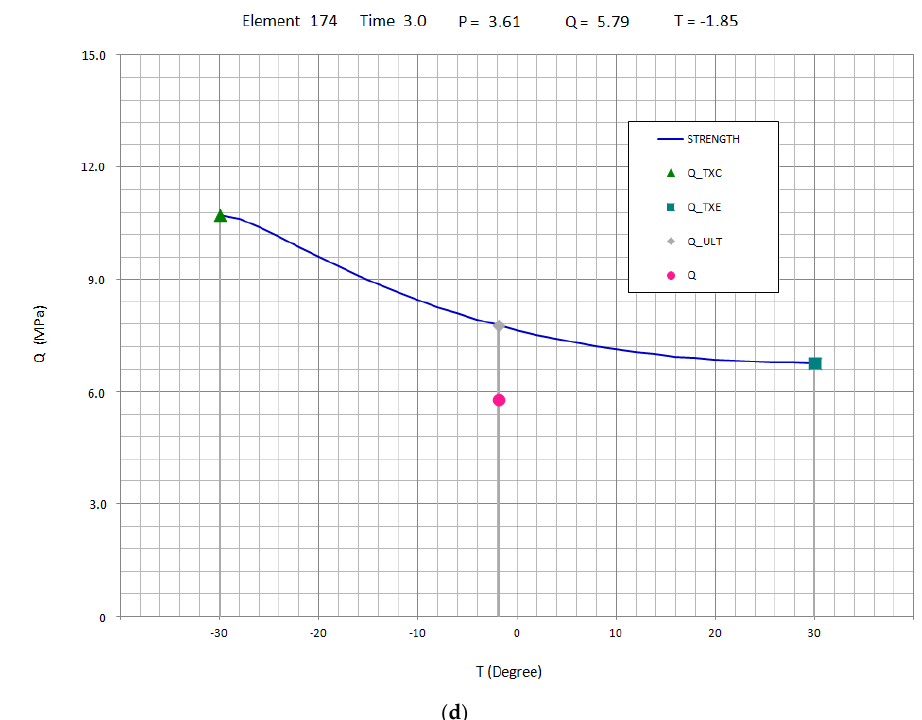
Figure 16 . Stress state at the first element along lines C5 and D6 (Ko = 1.0): ( a ) p – q plot at Location C; ( b ) t – q plot at Location C; ( c ) p – q plot at Location D; ( d ) t – q plot at Location D.